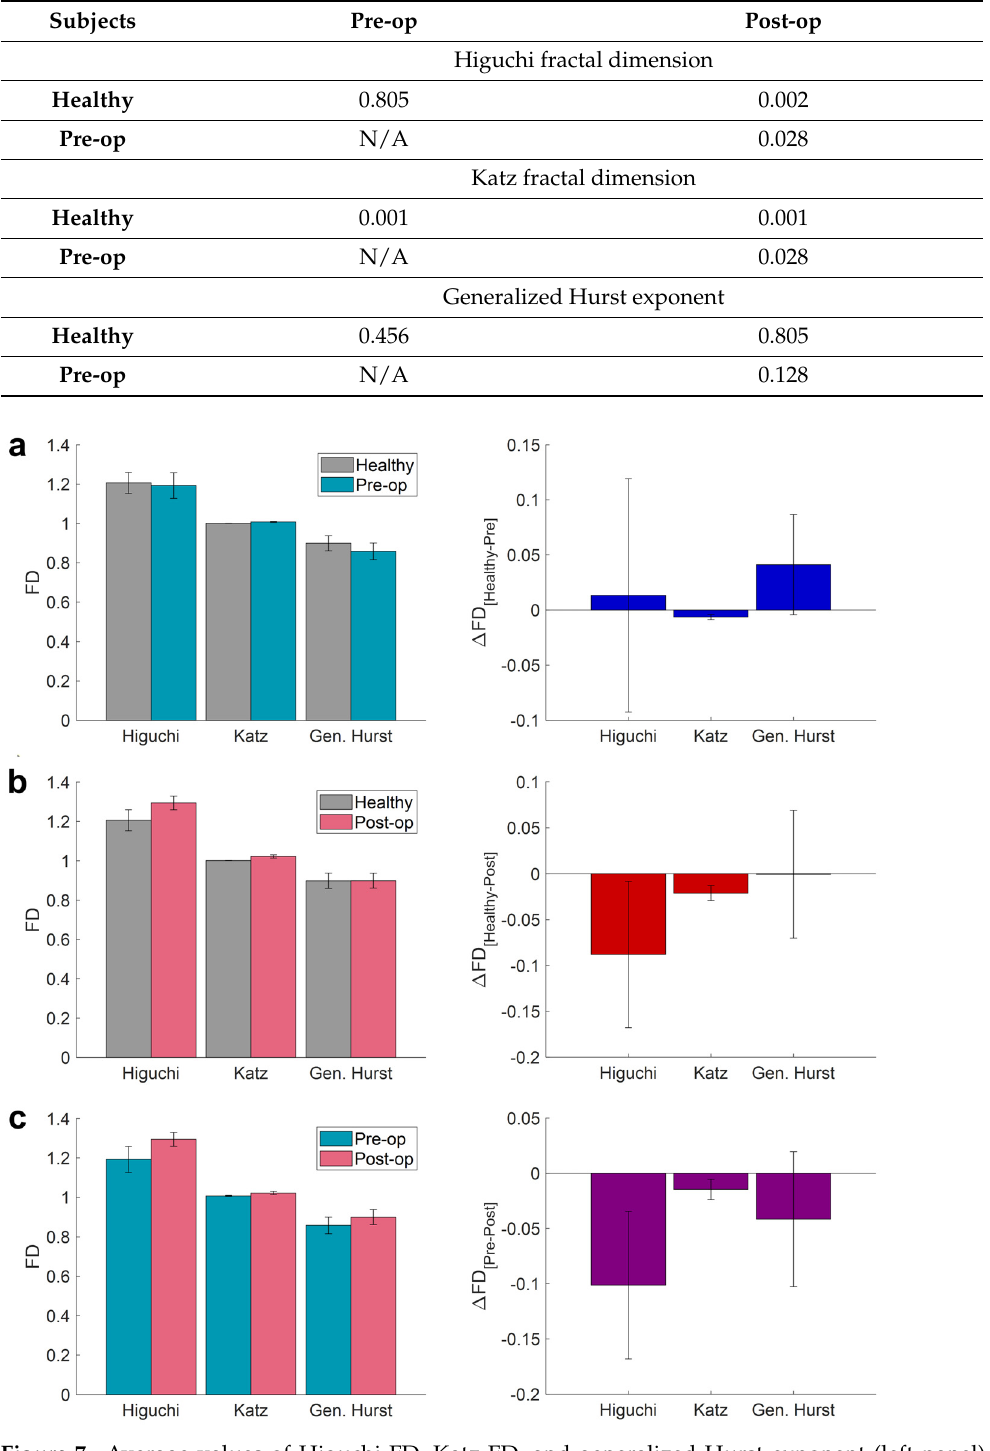
Figure 7. Average values of Higuchi FD, Katz FD, and generalized Hurst exponent (left panel) along with the difference in FD values (right panel) obtained from CURV measures for ( a ) healthy and pre ‐ op ( p ‐ value Higuchi = 0.805; p ‐ value Katz = 0.001; p ‐ value Hurst = 0.456), ( b ) healthy and post ‐ op ( p ‐ value Higuchi = 0.002; p ‐ value Katz = 0.002; p ‐ value Hurst = 0.805), and ( c ) pre ‐ op and post ‐ op ( p ‐ value Higuchi = 0.028; p ‐ value Katz = 0.028; p ‐ value Hurst = 0.128) conditions.